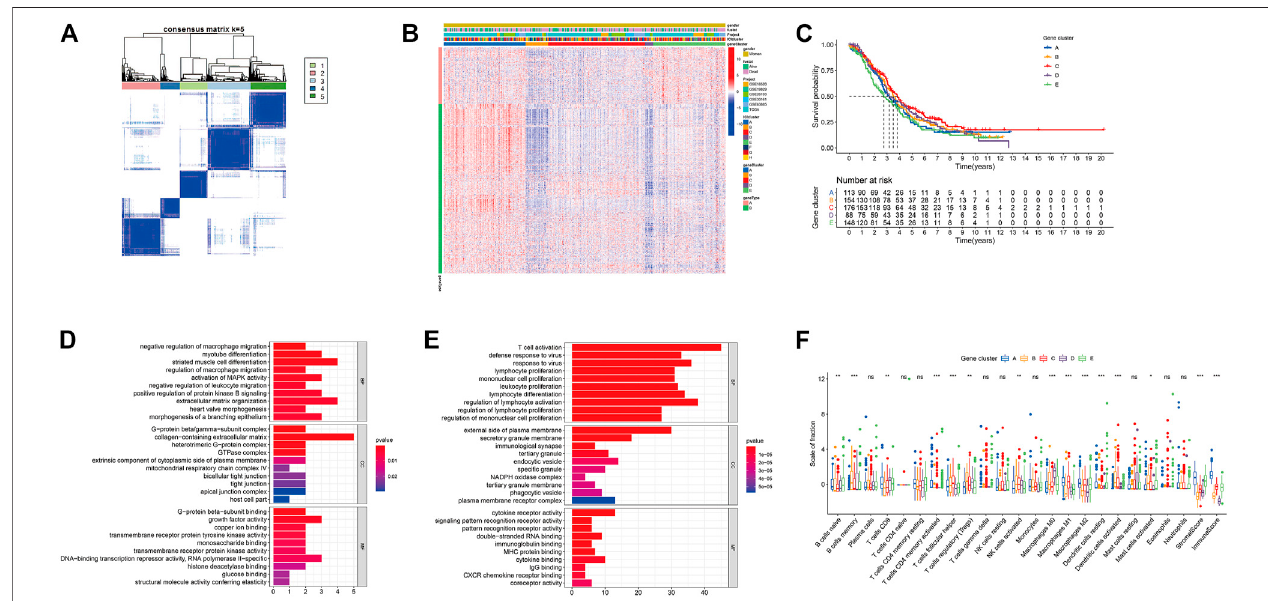
FIGURE3| Identi fi cationofimmunogenicgenesubtypes. (A) ConsensusmatrixesofallOCsamples(k (cid:1) 5). (B) UnsupervisedclusteringofcommonDEGamong5 ICIclustergroups. (C) Kaplan-Meiercurveofthe5groupsofpatients. (D) GOenrichmentanalysisofICIfeaturegenesetA. (E) GOenrichmentanalysisofICIfeaturegene set B. (F) The proportion of tumor in fi ltrating immune cells in the 5 gene clusters (* p < 0.05; ** p < 0.001; *** p < 0.001; ns means statistical difference).